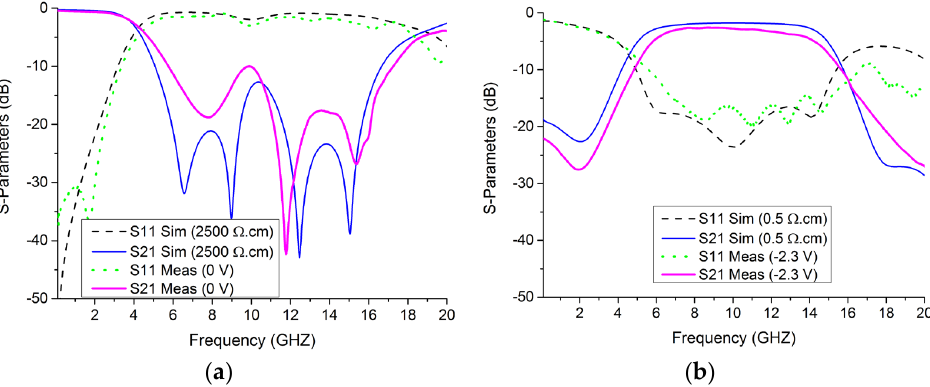
Figure 19. Comparison between the simulated and the measured results of the 10 GHz filter. ( a ) In the OFF-state. ( b ) In the